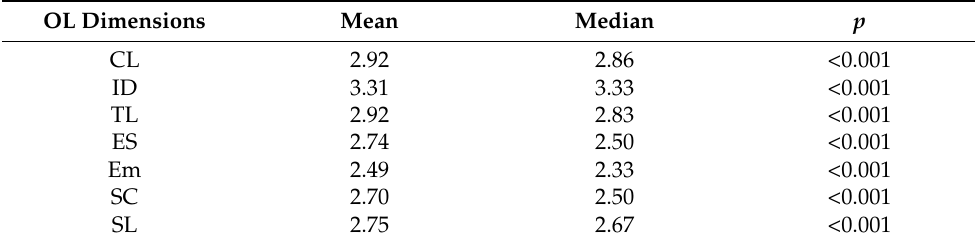
Table 3. One-sample Wilcoxon signed rank OL